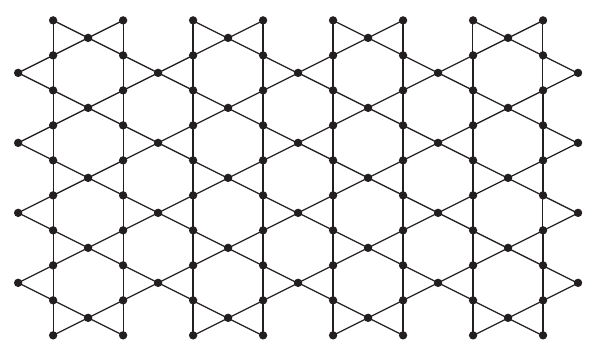
Figure 1: The hexagon star network sheet for l � 4 and w � Table 1: ev-Degree of G l,w .